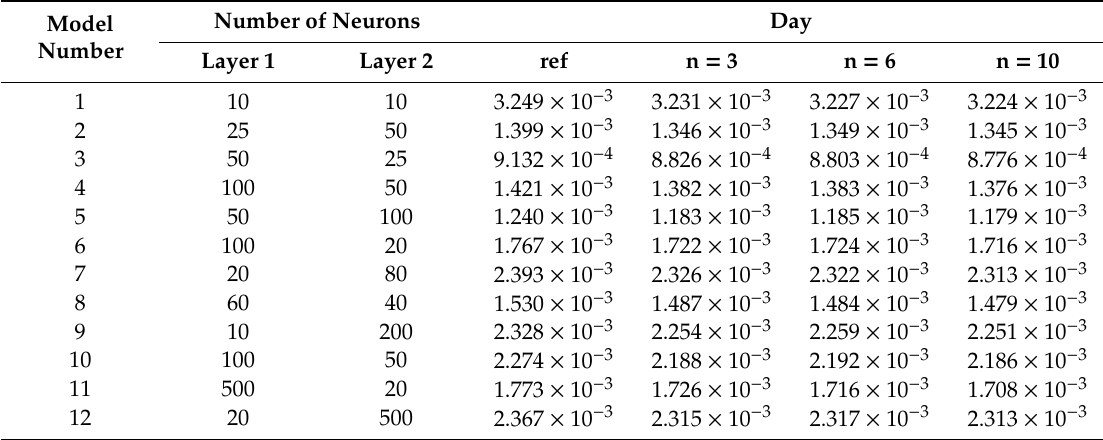
Table 8. MSE values for the reference signals and wavelet-based filtered